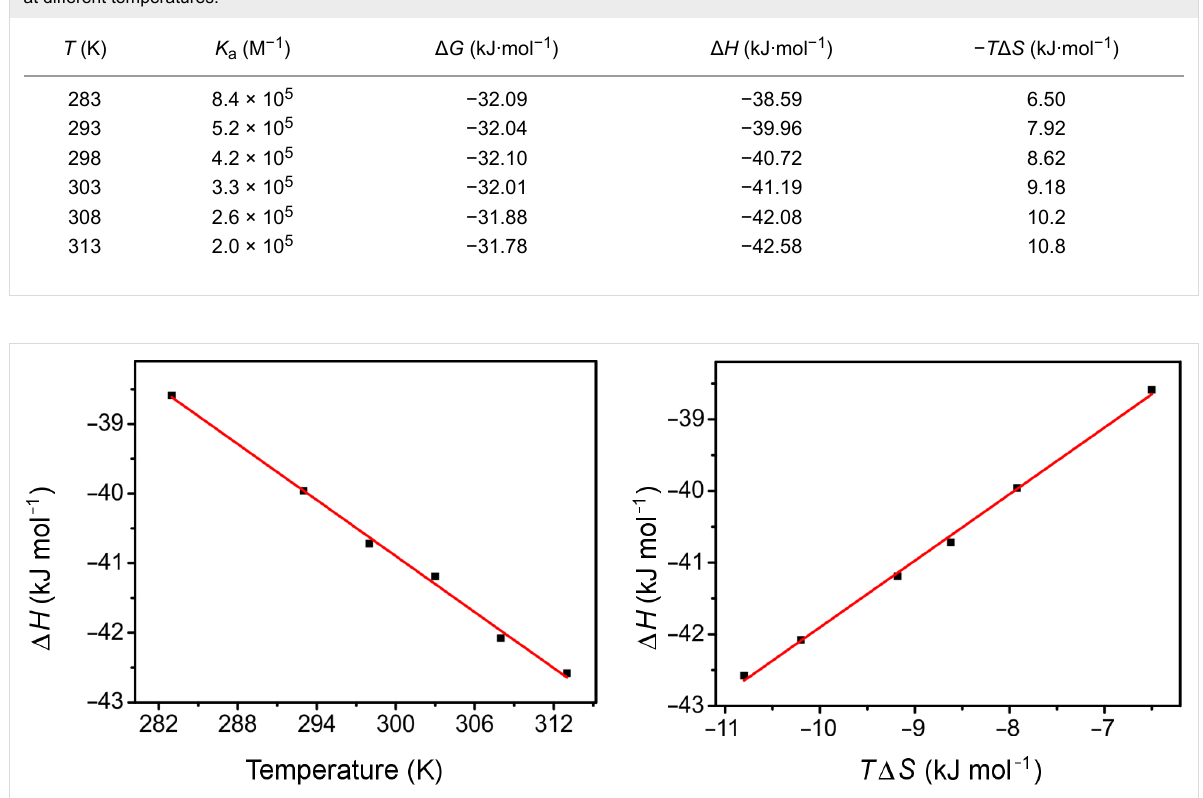
Figure 5: Linear relationships of Δ H with temperature (left, slope = − 0.13, R 2 = 0.9956) and T Δ S (right, slope = 0.93, R 2 = 0.9976).